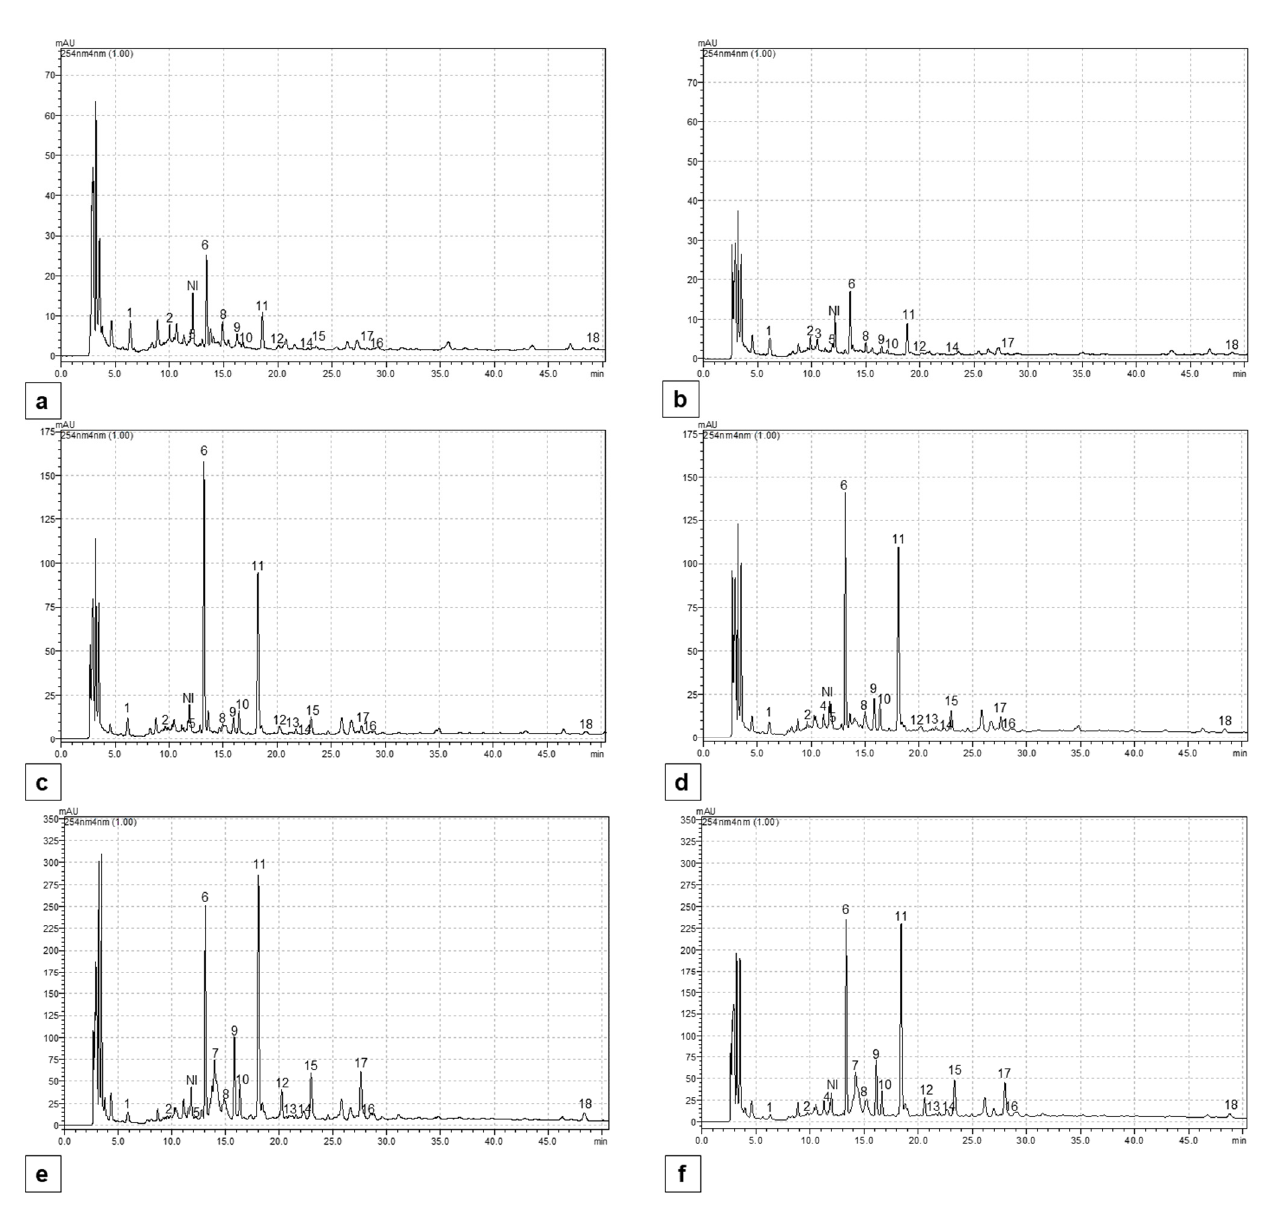
Figure A1. Chromatographic profile of the phenolic acids and flavonoids at 254 nm for different parts of the Spergularia marina : roots in slight ( a ) and strong ( b ) soil salinity, shoots in slight ( c ) and strong ( d ) soil salinity, inflorescence in slight ( e ) and strong ( f ) soil salinity. 1—3,4-dihydroxybenzoic acid; 2—catechin; 3—chlorogenic acid; 4—luteolin derivative; 5—epicatechin; 6–12—apigenin derivative; 13, 14—tricin derivative; 15—chicoric acid; 16—tricin derivative; 17—rosmarinic acid; 18—hesperetin; NI—not identified.